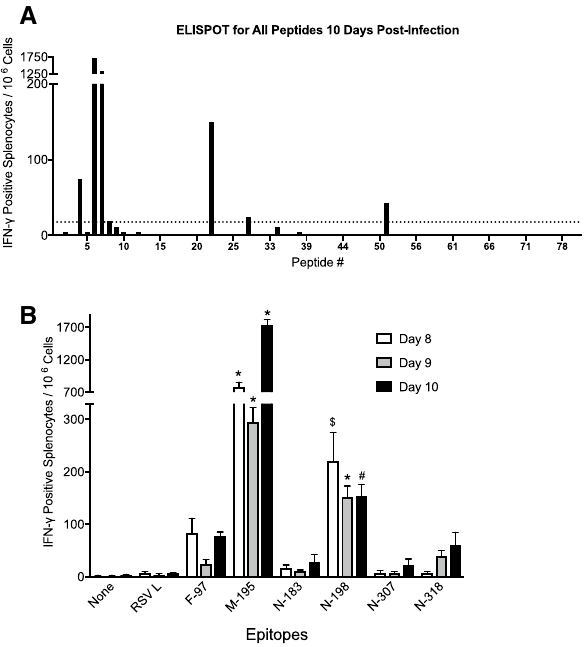
Figure 1. HMPV peptides are recognized by IFNγ-producing cells in HLA-B7 transgenic mice. B6-Kb 0 Db 0 ;HLA-B*07:02 transgenic (B7tg) mice were infected i.n. with 1 × 10 6 PFU HMPV and splenocytes isolated 10 days post-infection. HMPV immune cells were screened for IFNγ release via ELISPOT assay using ( A ) 80 HLA-B*07:02 predictopes or ( B ) 6 selected HMPV epitopes and an irrelevant RSV epitope. Results indicate spot forming cells (SFC) per 10 6 splenocytes following stimulation with the indicated peptide. Data are